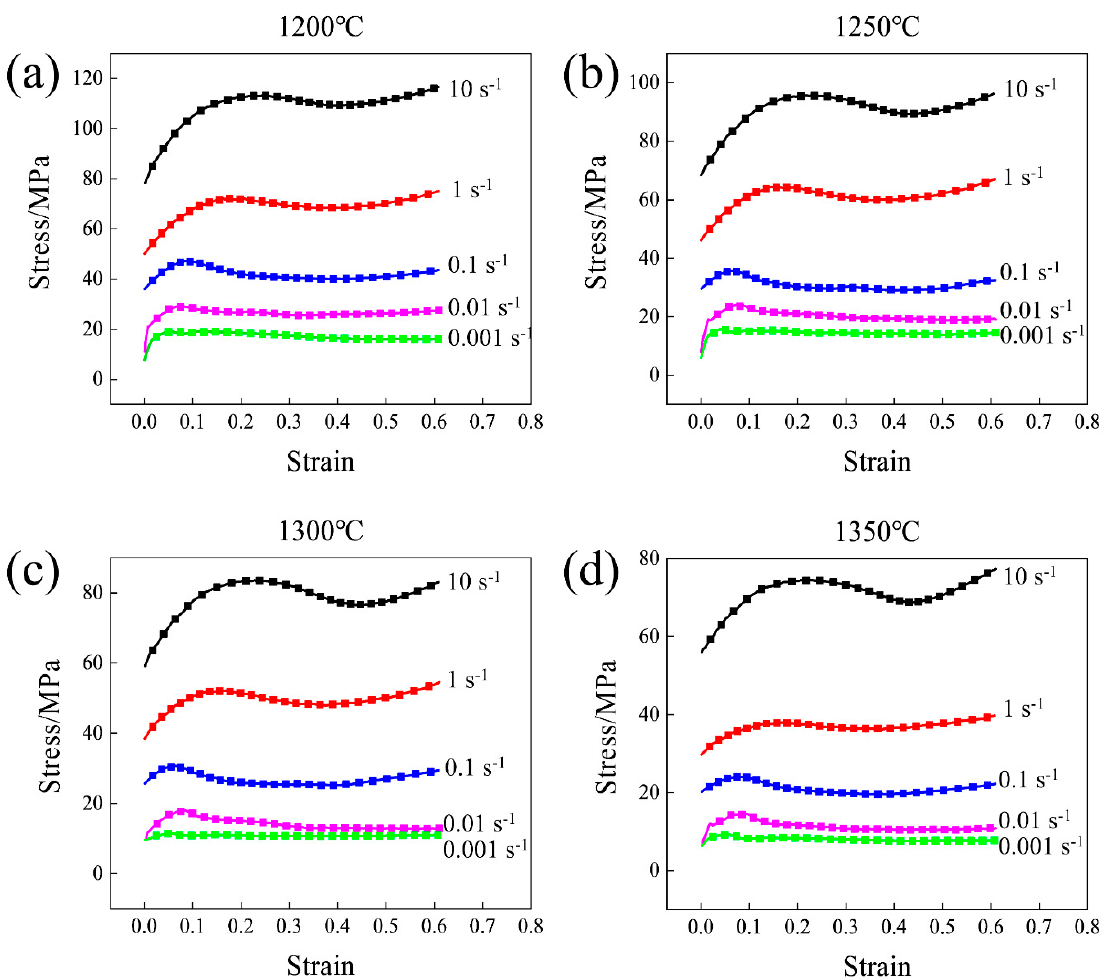
Figure 7. Predicted and experimental data of flow stress from BP ANN model at various strain rates and temperatures: ( a ) 1200 °C ; ( b ) 1250 °C ; ( c ) 1300 °C ; ( d ) 1350 °C .